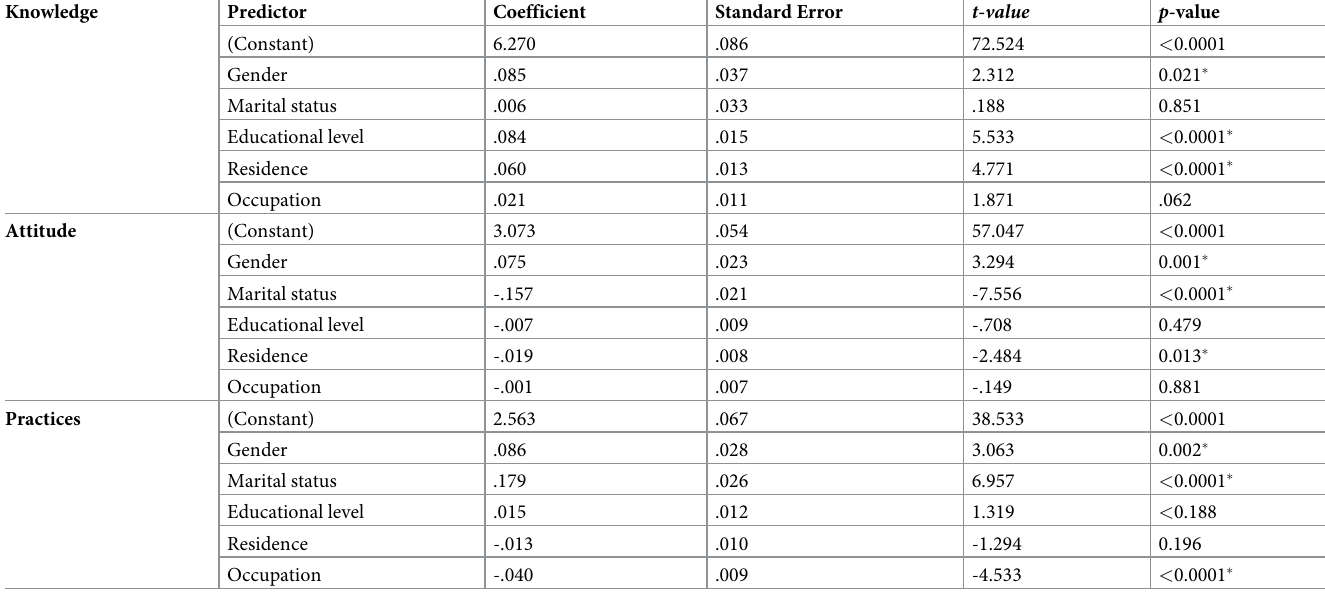
Table 3. Association between demographics and the participant knowledge, attitude, and practice score using multiple linear regression analysis.